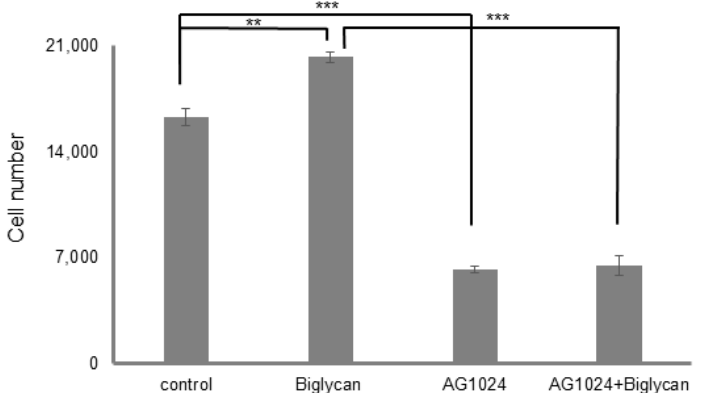
Figure 8. Role of IGF-IR on biglycan-dependent MG63 cell proliferation. MG63 cells were harvested and seeded on 96-well plates and were allowed to rest overnight. The next day, cells were treated with serum-free medium for 24 h. Cells, in each well, incubated with 0% FBS-medium (control), 10 μ g/mL biglycan, 10 μ M AG1024 and 10 μ g/mL biglycan + 10 μ M AG1024 for 48 h (30 min pre-treatment). Cells were counted using fluorometric CyQUANT assay kit. Results represent the average of three separate experiments. Means ± S.E.M were plotted; statistical significance: *** p ≤ 0.001, ** p ≤ 0.01 compared with the respective control samples.